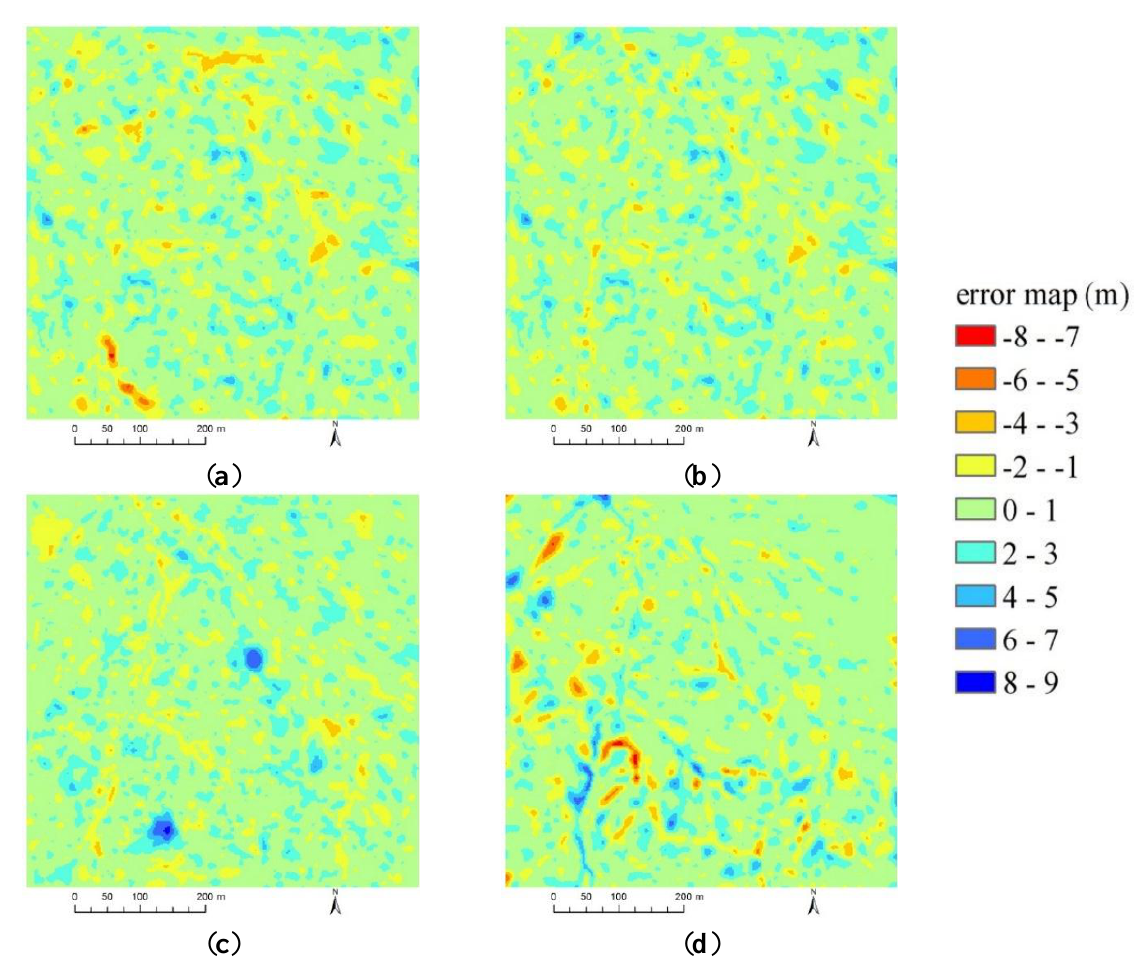
Figure 8. Hillshades of ( a ) TPS-F, ( b ) TPS-W, ( c ) max-Z and ( d ) random with1% of LiDAR points in the hilly site.